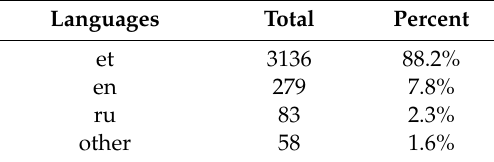
Table A15. Primary languages (ee).